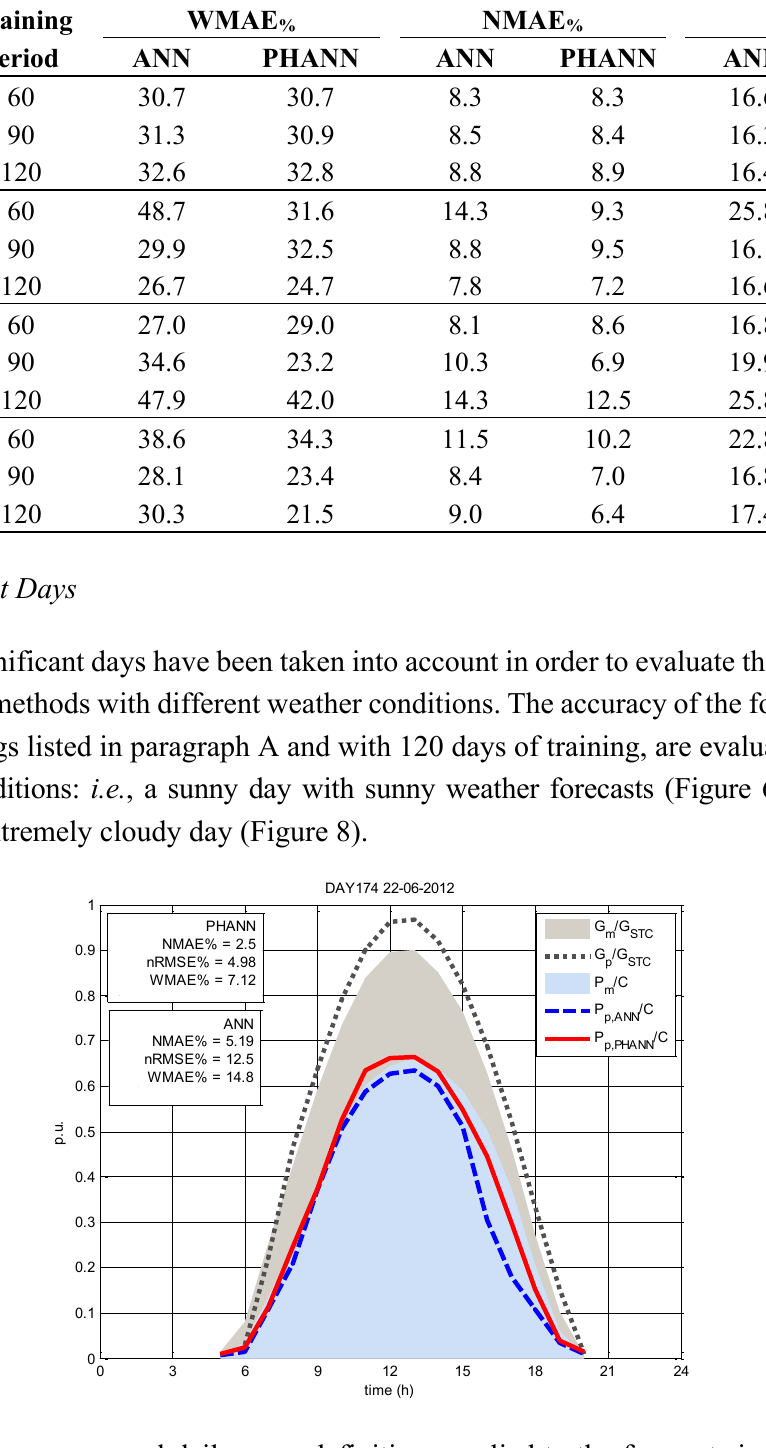
Figure 6. Power curves and daily error definitions applied to the forecasts in a sunny